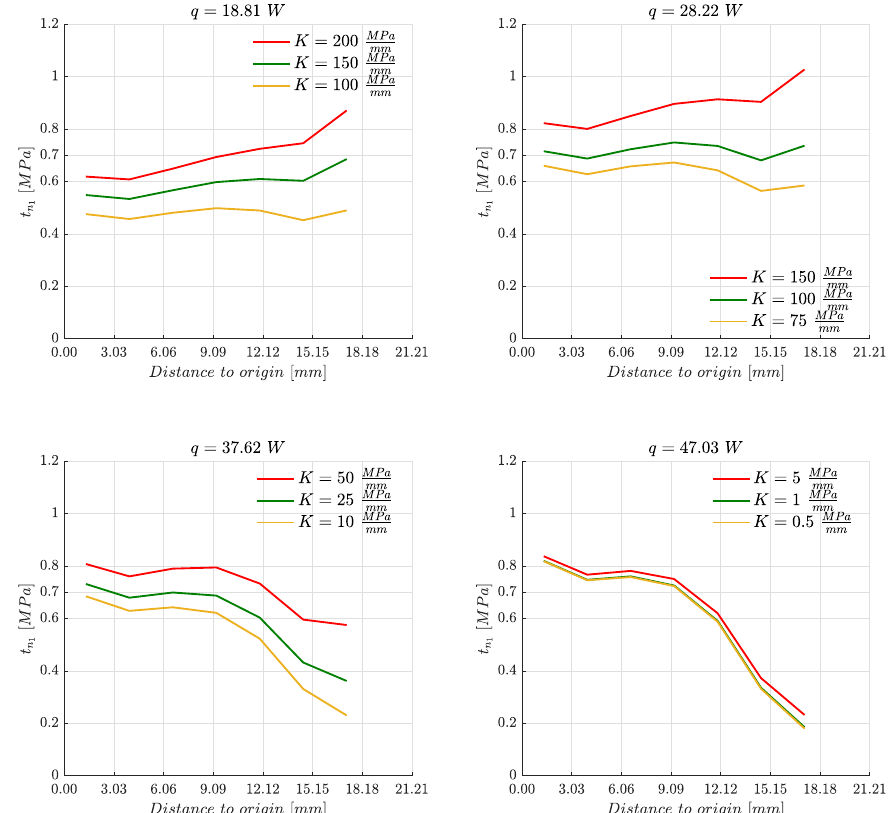
Figure 18. Normal traction distribution at the nodes located at the diagonal of the contact zone of all the stiffness of the retaining mechanism analyzed for: q = 18.81 W, q = 28.22 W, q = 37.62 W and q = 47.03 W.